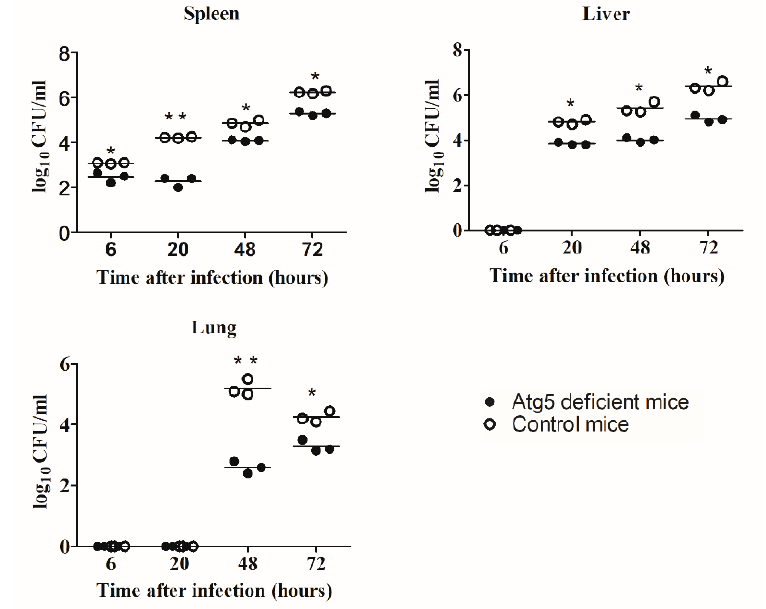
Figure 2. Growth kinetics of the LVS in the spleen, liver, and lungs of the Atg5-deficient and control mice. Each group of mice was infected intradermally with 5 × 10 4 bacteria per mouse. To determine the bacterial loads in the lung, liver, and spleen, organs were harvest and homogenized. Three mice per group were used in this experiment. Mean values are indicated. * p < 0.05, ** p < 0.001 were considered significant in comparison to the control mice.